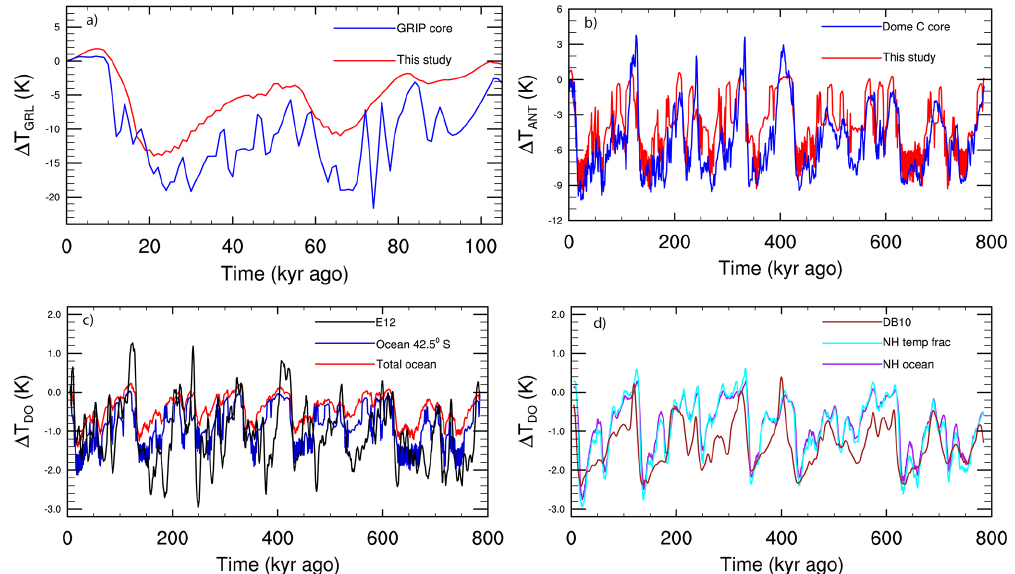
Figure 5. (a) Modelled reference Greenland temperature anomaly from PI (red), compared to the 2kyr smoothed data reconstruction (Johnsen et al., 1995) based on δ 18 O from the GRIP core (GRIP members, 1993, blue). (b) Modelled reference Antarctic temperature anomaly from PI (red), compared to a reconstruction based on the deuterium isotope record of the Dome C ice core (Jouzel et al., 2007, blue). (c) Modelled reference deep-ocean temperature anomaly from PI, globally averaged (red), and at 42.5 ◦ S (blue), compared to a reconstruction from the Mg / Ca ratio of a sediment core (Elderfield et al., 2012 [E12], black) drilled at 41 ◦ S. (d) Modelled reference NH (40–80 ◦ N averaged) deep-ocean temperature anomaly from PI (purple), compared to model output from De Boer et al. (2010) ([DB10], brown) and the modelled reference NH atmospheric temperature anomaly from PI multiplied by a factor of 0.2